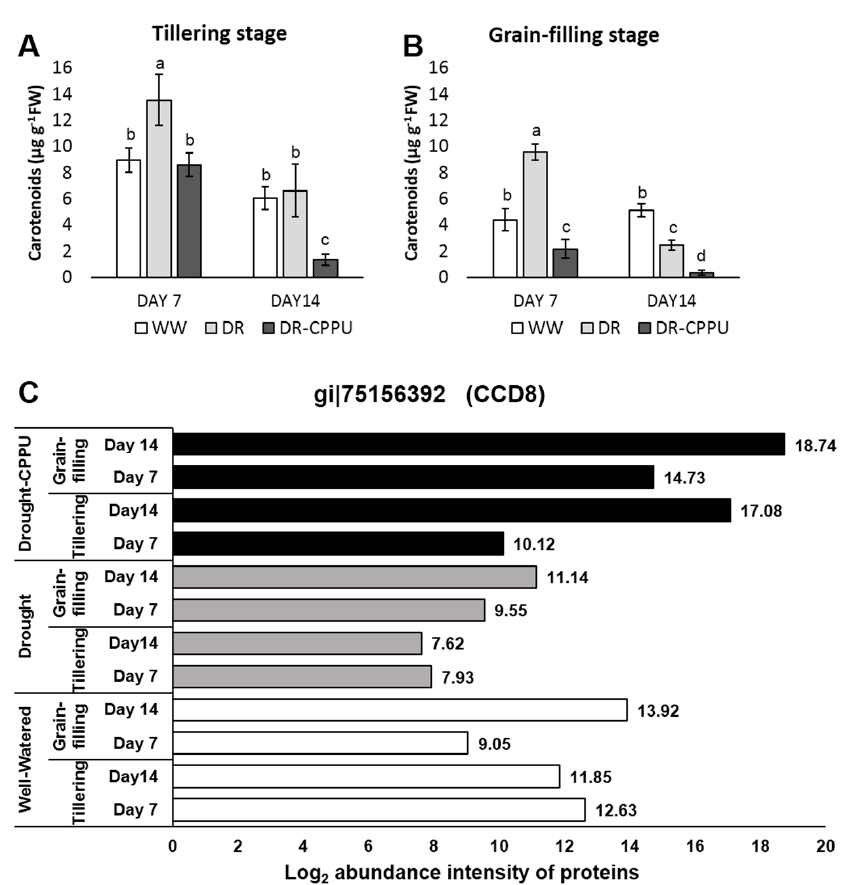
Figure 8. Total carotenoid contents ( µ g g − 1 FW) quantified from rice leaves under di ff erent treatment conditions at tillering ( A ) and grain-filling ( B ) stages. WW = Well-watered plants (soil moisture tension of − 15 kPa), DR = Drought stressed plants (Soil moisture tension of − 55 kPa and − 72 kPa at day 7 and day 14, respectively), and DR-CPPU = Drought stressed plants, sprayed with 5 mg / L CPPU on day 6 of drought treatment. Error bars represent SD (standard deviation). Letters viz. a, b, c, d, e, over SD bars indicate the highly significant di ff erences of mean at p < 0.01 (**), as analyzed by Duncan’s Multiple Range Test (DMRT). ( C ) Influence of synthetic cytokinin and drought on the abundance intensities of the Carotenoid cleavage dioxygenases 8 (CCD8) protein involved in oxidative degradation of carotenoids at the tillering and grain-filling stages of the rice. Protein abundance intensities, represented on the X- axis, are the highest log2 fold change values of technical replicates. [Well-Watered plants were maintained at a soil moisture tension of − 15 kPa during the treatment period. Drought stress was imposed by withholding water for up to 14 days. Soil moisture tensions of − 55 kPa and − 72 kPa were recorded at day 7 and day 14 during the treatment, respectively. CPPU treatment was given by foliar spraying plants with a 5 mg / L solution of CPPU at the rate of 25 mL / plant on day 6 of drought